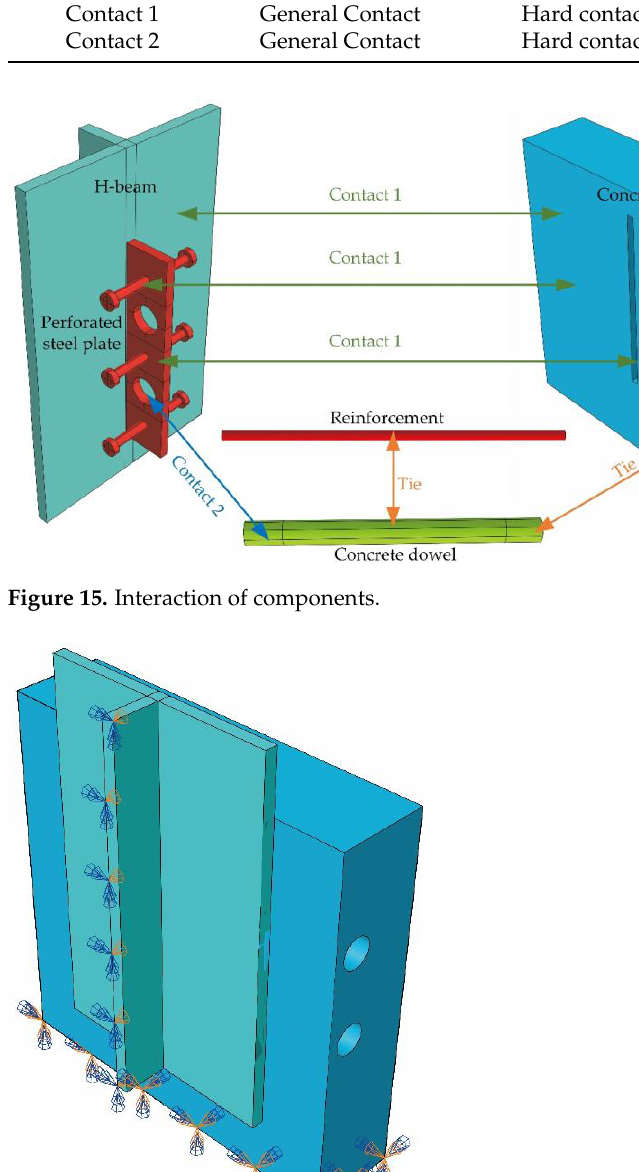
( c ) Figure 17. Material constitutive relationships: ( a ) concrete in compression; ( b ) concrete in tension; ( c ) other materials.